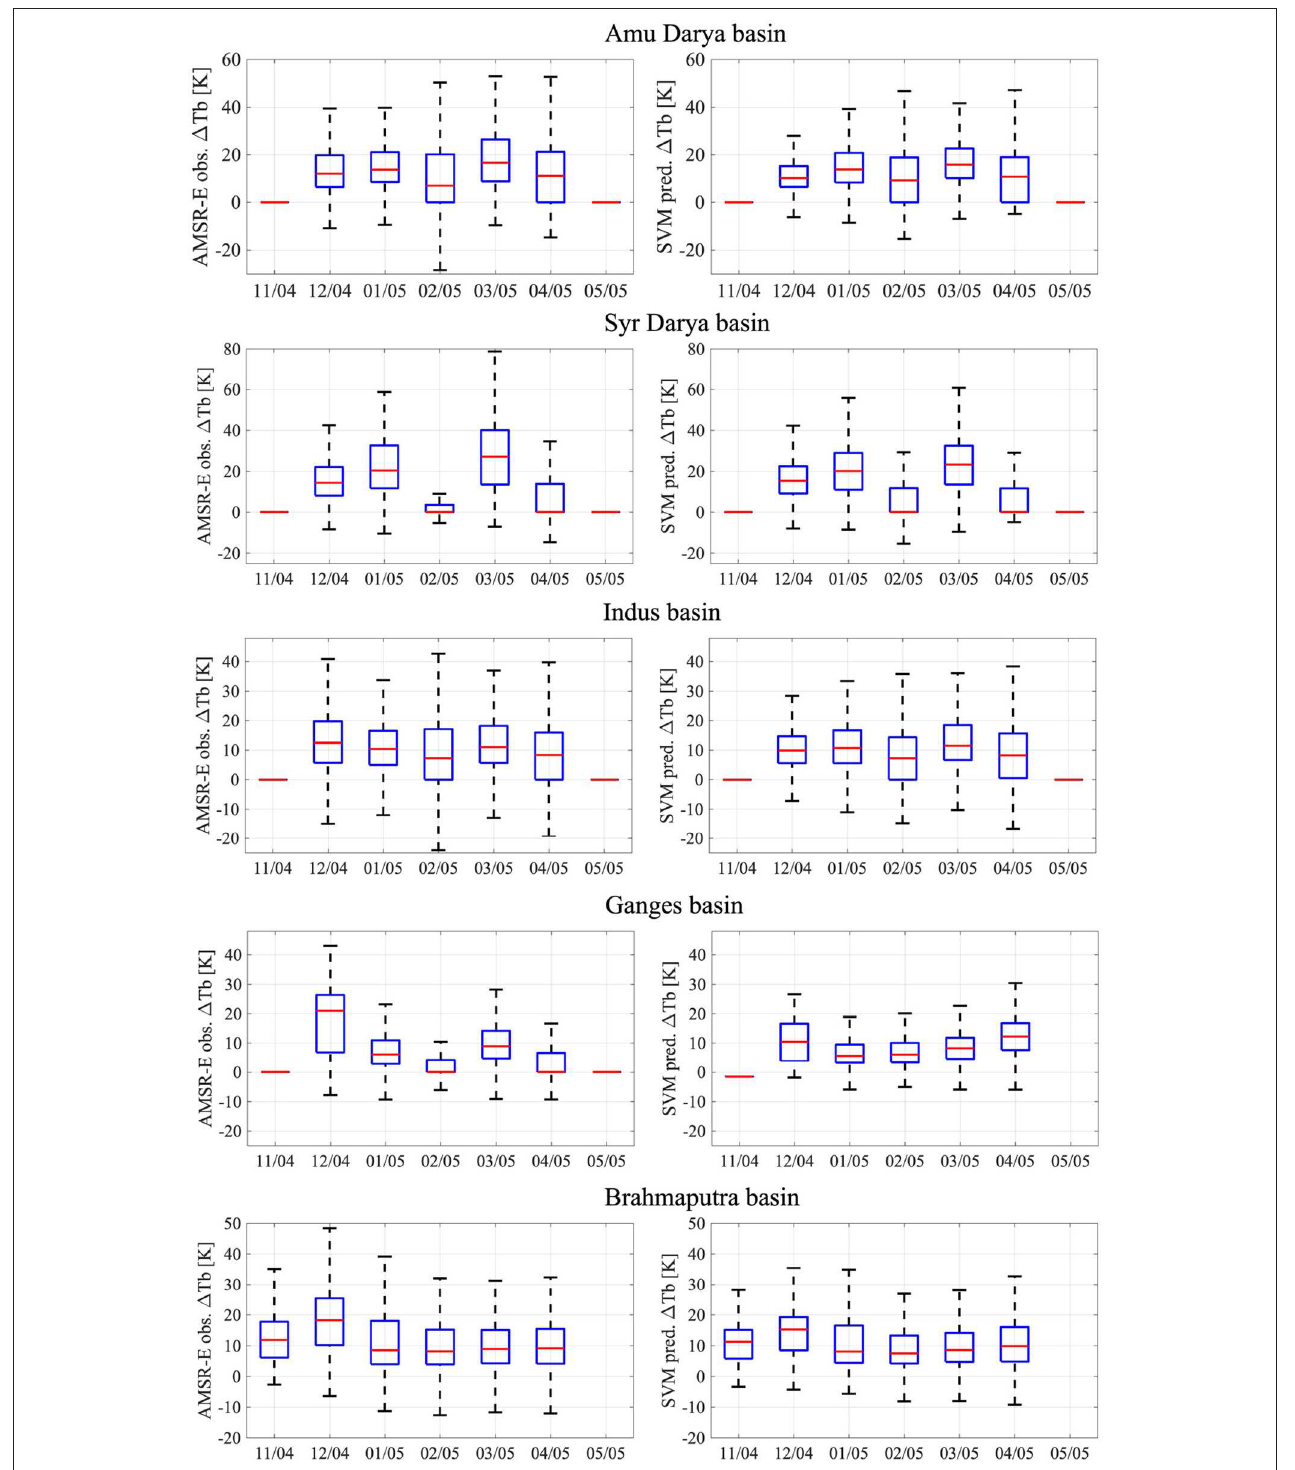
FIGURE 4 | Seasonal variability in (Left) observed AMSR-E 1 Tb and (Right) SVM-predicted 1 Tb for the five major river basins in HMA. Only the 2004–2005 snow season is presented here for visual clarity. Box plots for each month include 1 Tb values from locations with a simulated SWE > 1 cm for all the pixels within the basin boundary. The blue box represents the inter-quartile range (IQR), the red line is the median, and the whiskers encompass 25% percentile − 1.5*IQR and 75% percentile + 1.5*IQR, respectively.